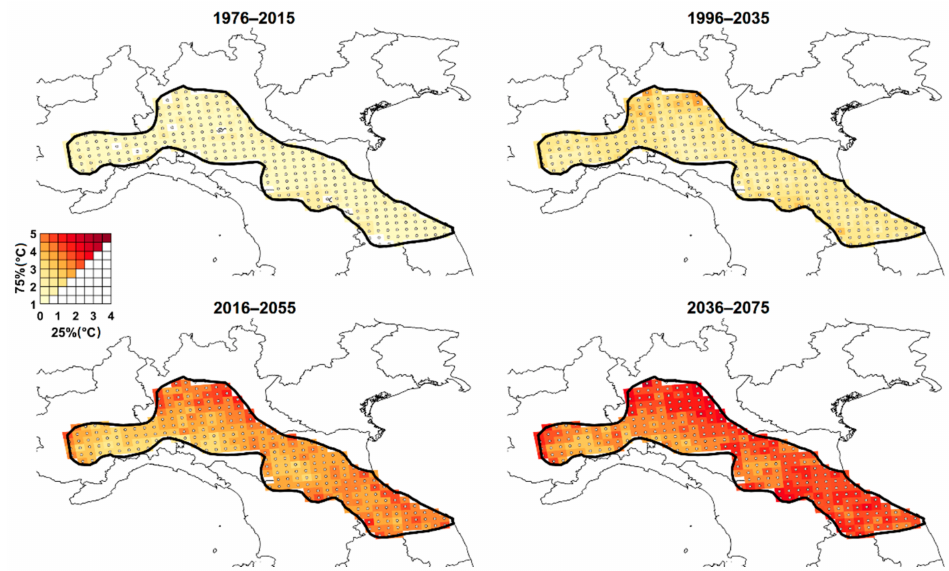
Figure 6. Factors of change for T Max,k in the time windows 1976–2015, 1996–2035, 2016–2055, and 2036–2075 in comparison with the reference time interval 1956–1995—prediction interval (25–75%) map (Scenario